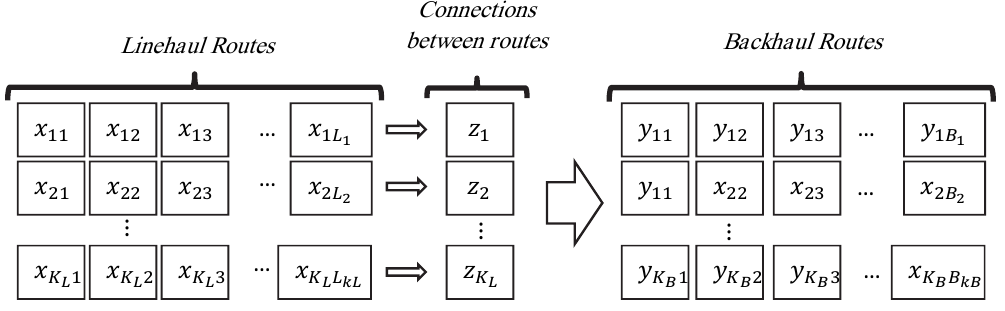
Linehaul Routes